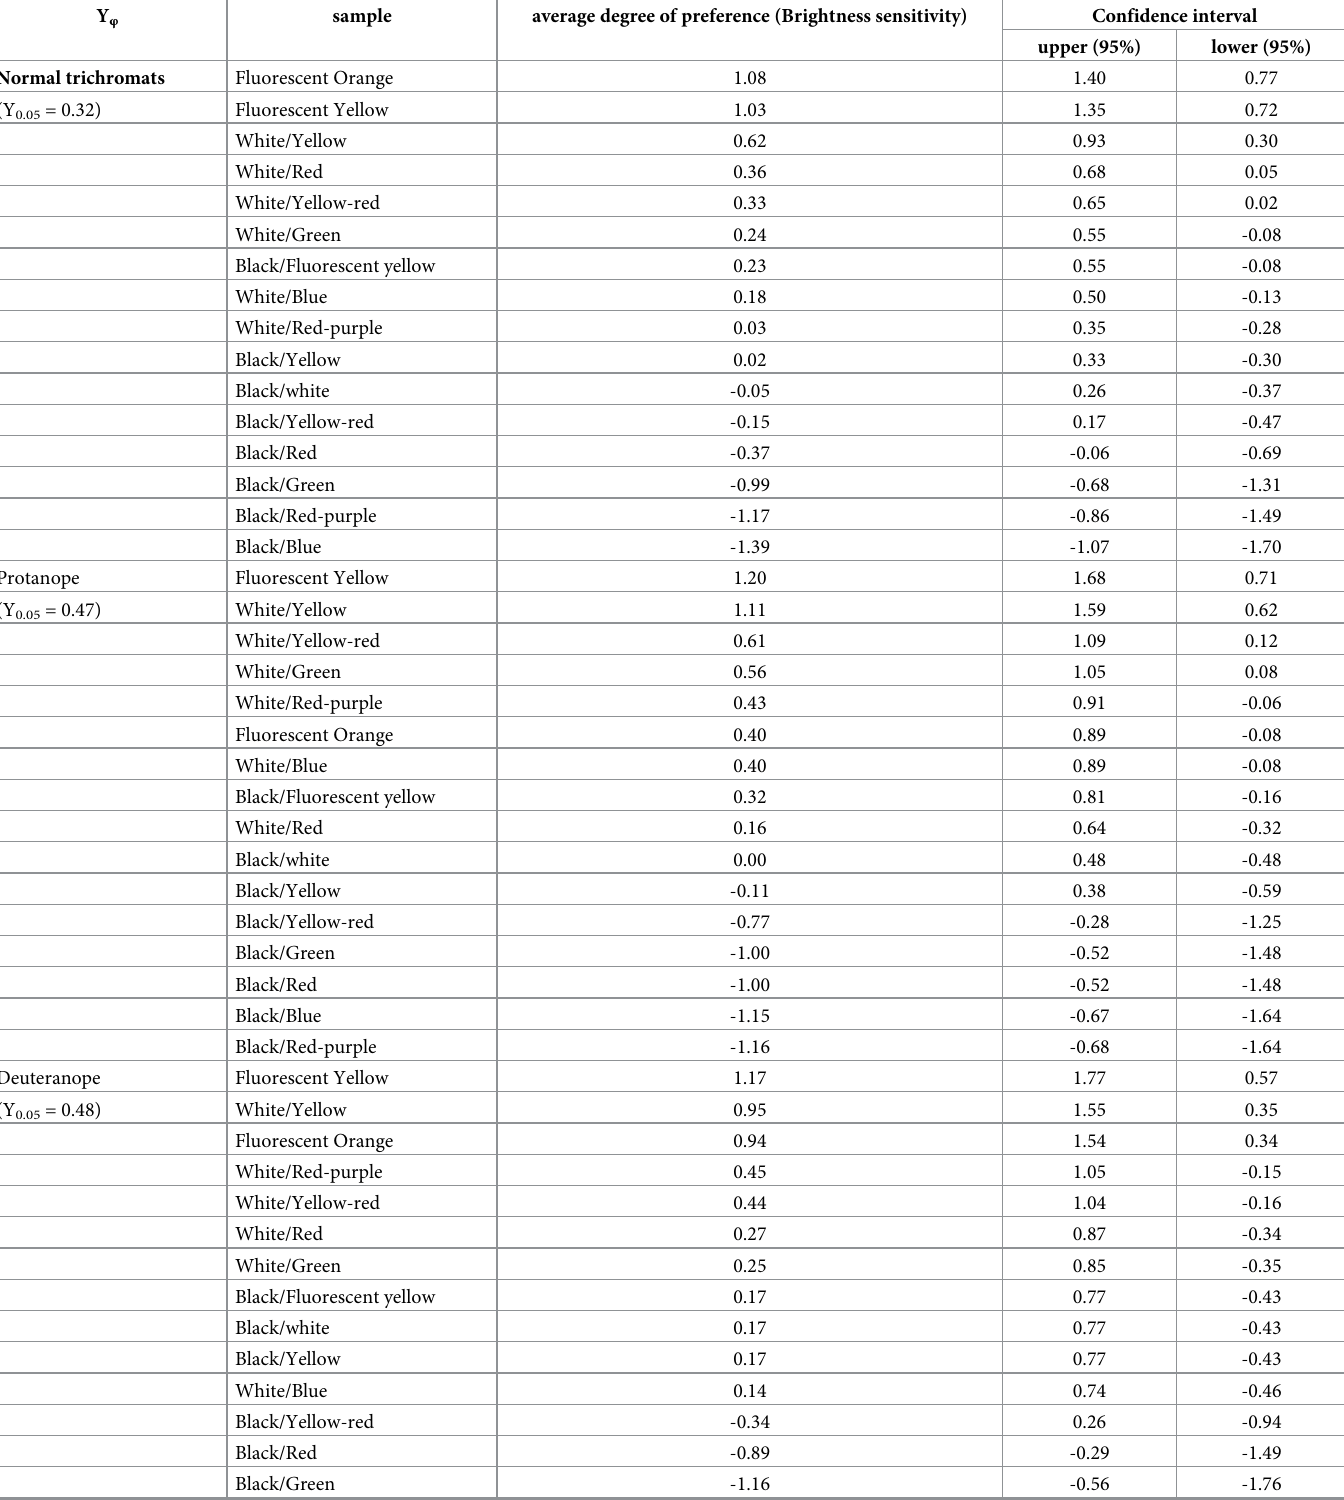
Table 3. Results of 95% confidence intervals and average degree of preference (Brightness sensitivity) for the sample using Scheffe´’s method. Y